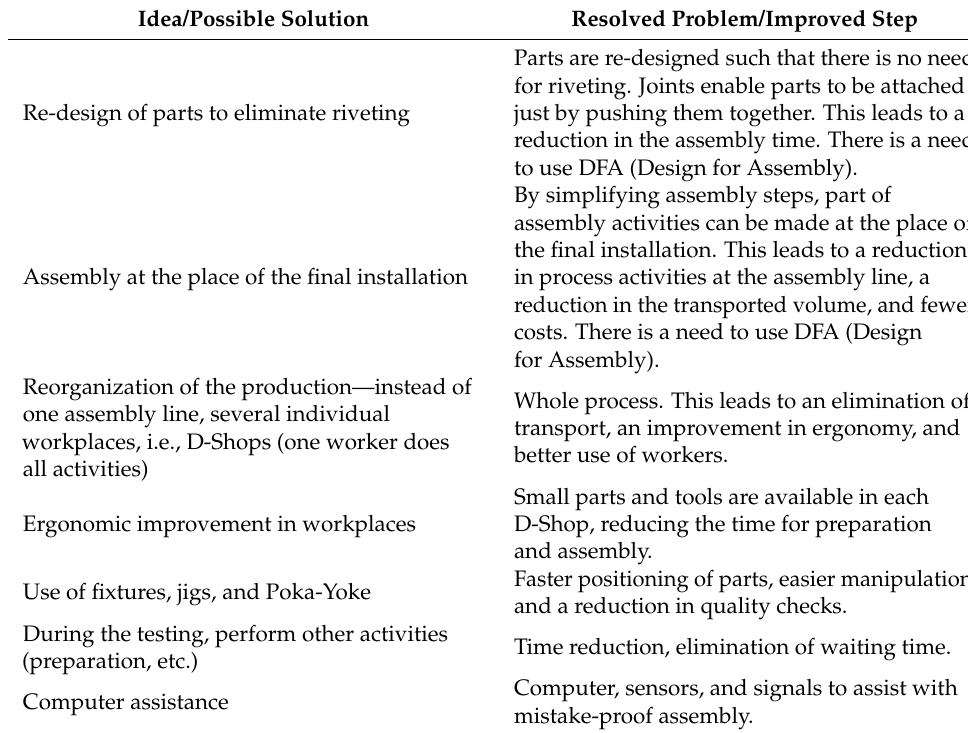
Table 4. Final list of ideas—assembly